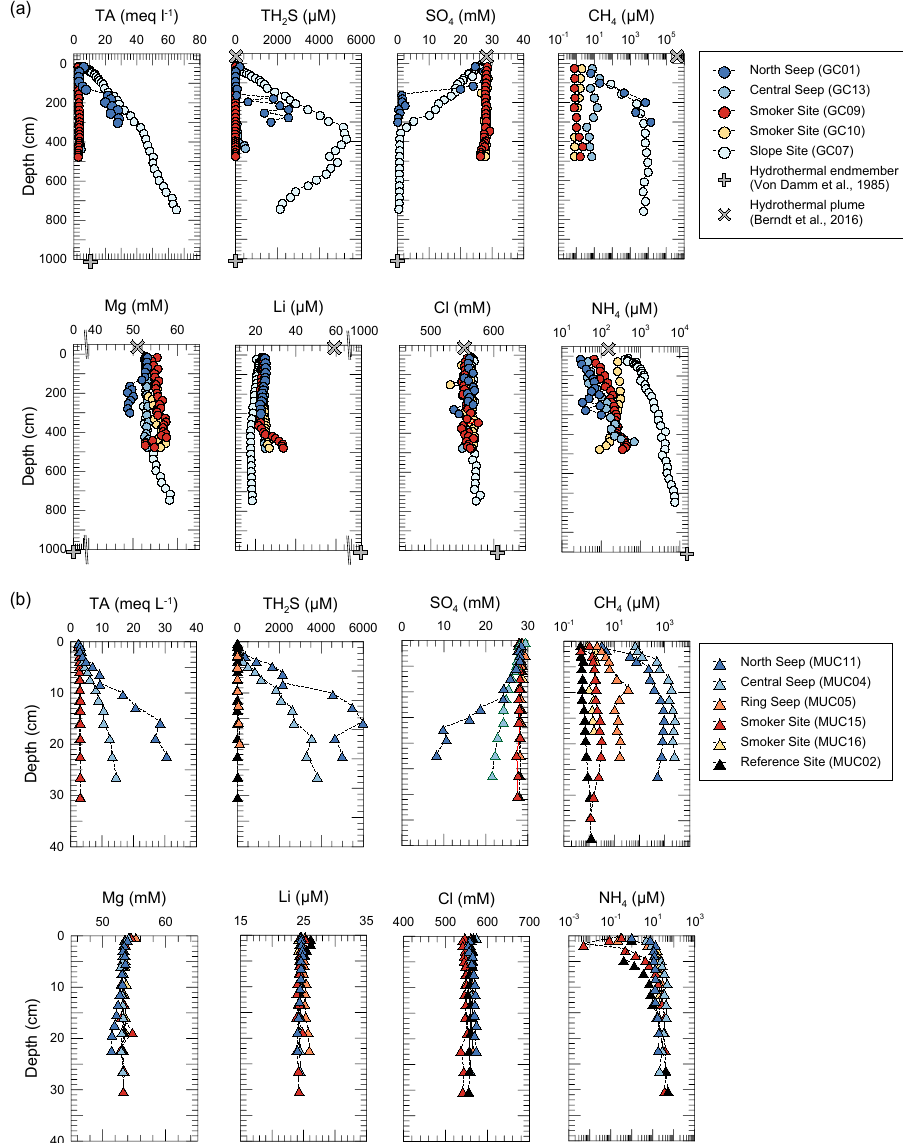
Figure 4. Pore water profiles of GCs (a) and MUCs (b) . For the Central Seep, GC13 is shown here as an example, and geochemical data of the remaining cores (GC03, 15) can be found in Table S1. Endmember composition of hydrothermal solutions from Von Damm et al. (1985) and hydrothermal plume geochemical composition from Berndt et al. (2016) are shown in (a) for comparison.